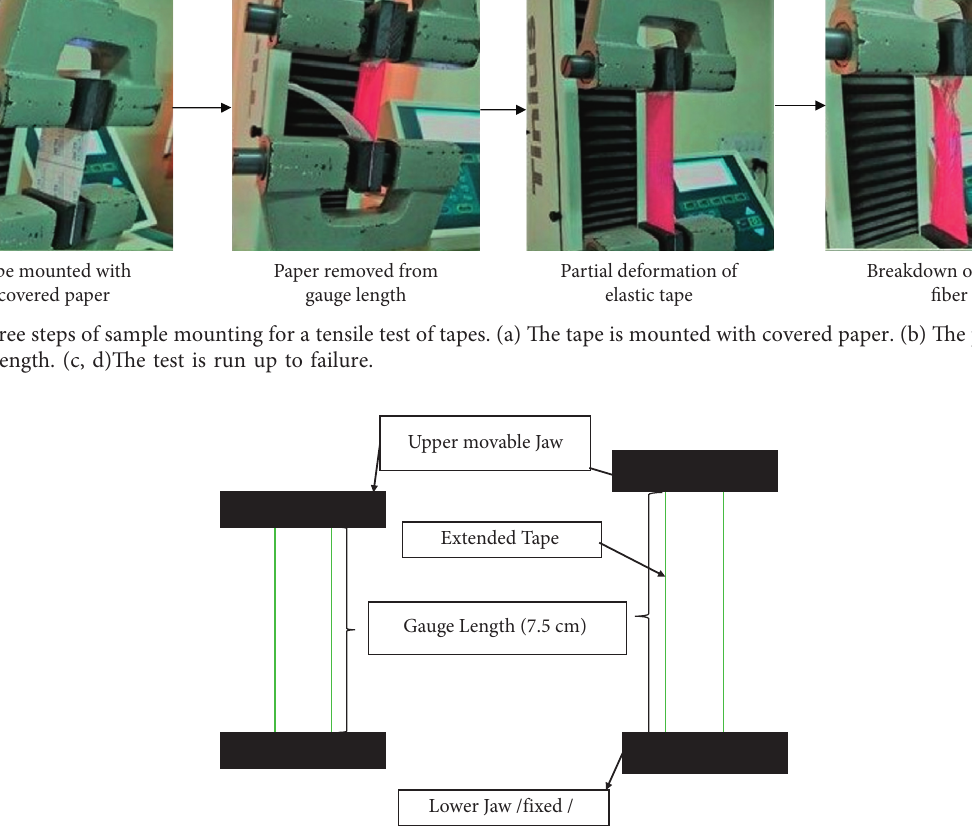
Figure 4: Method of the stress relaxation test under 25% and 50% level of